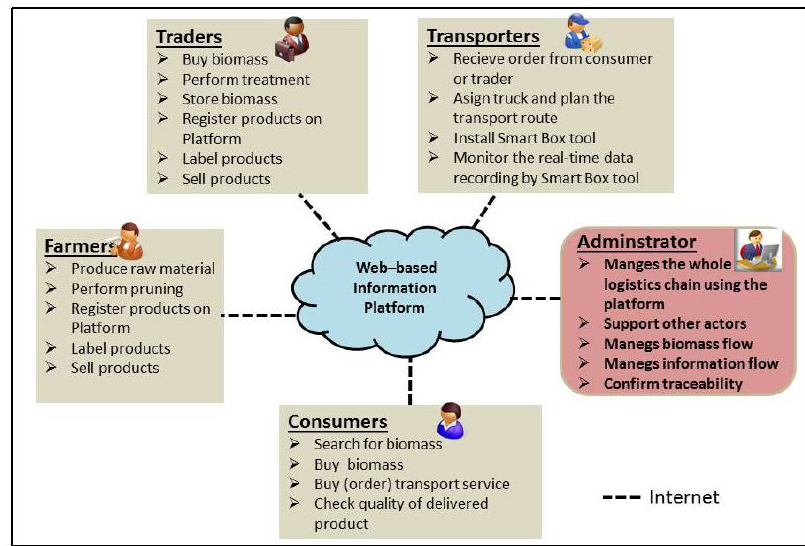
Figure 7. Major activities of different users of the platform. In order to allow the actors to perform the activities indicated, the platform has modules and links to defined actions making the platform more user friendly.